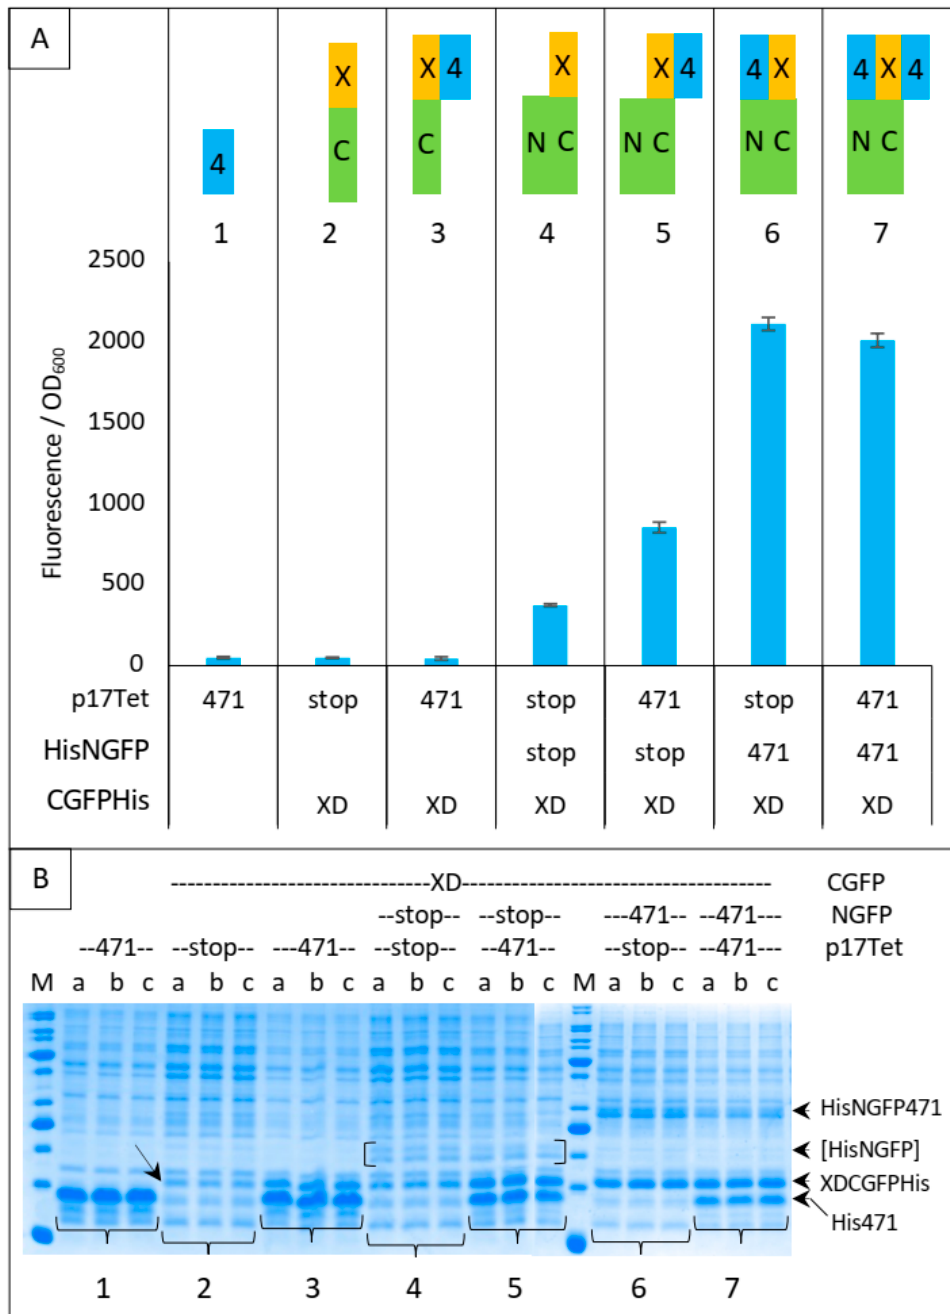
Figure 5. XDCGFP bound to 471 and/or NGFP is protected from degradation as assessed by fluorescence measurements after one night at 17 °C and SDS-PAGE analysis. In this experiment, XDCGFP is his-tagged. ( A ) Top panel: the different proteins and protein combinations, numbered from 1 to 7, are illustrated by colored rectangles: 471 = 4 in blue rectangle, XD = X in yellow rectangle,